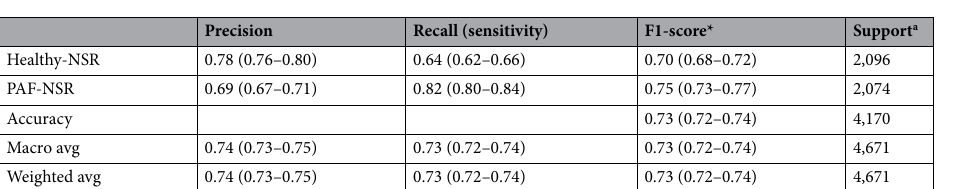
Table 2. AI model performance. Data in parentheses represent the 95% confidence intervals. AI artificial intelligence; avg average; PAF paroxysmal atrial fibrillation. *F1 Score (balanced F-score) is the harmonic mean of precision and recall, and calculated as follows: F1 score = 2 (precision × recall) / (precision + recall). a Support is the number of occurrences of each class when it is